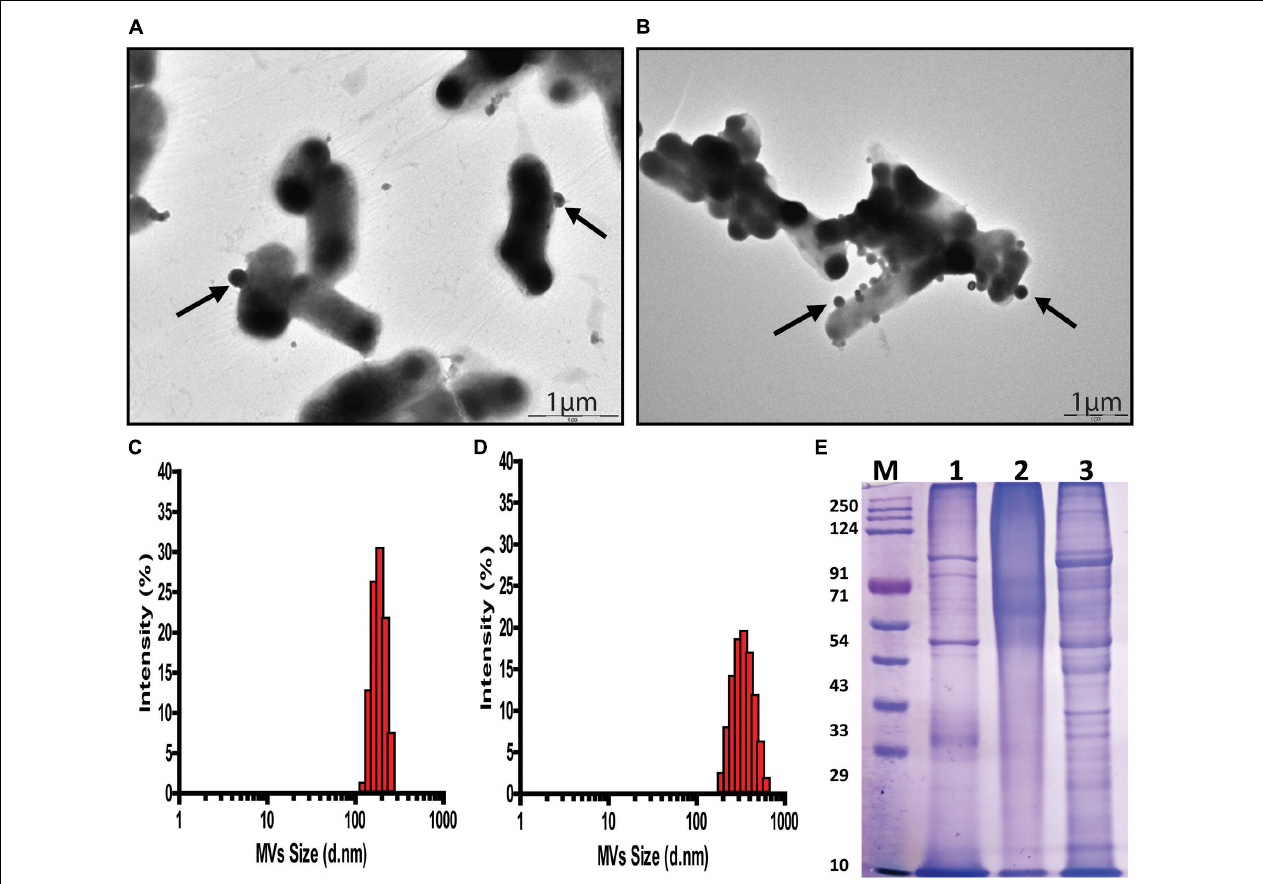
FIGURE 2 | pH dependent changes in G. vaginalis ATCC 14019 membrane vesicles (MVs). Transmission Electron Microscopy (TEM) of negatively stained preparation of G. vaginalis cells showing released MVs attached to the cell surface (arrow) at pH 6.5 (A) and pH 3.5 (B) ; scale bar-1 µ m. Size distribution profile of MVs measured by dynamic light scattering indicates a diameter range of 190–250 nm at pH 6.5 (C) and 190–615 nm at pH 3.5 (D) . SDS-PAGE profile of G. vaginalis MVs isolated from (1) cells grown at pH 6.5, (2) cells grown at pH 3.5, and (3) cell free supernatant (cells grown at pH 6.5) supplemented with lactic acid to produce acidic conditions (pH 3.5) and (M) molecular weight marker (E)